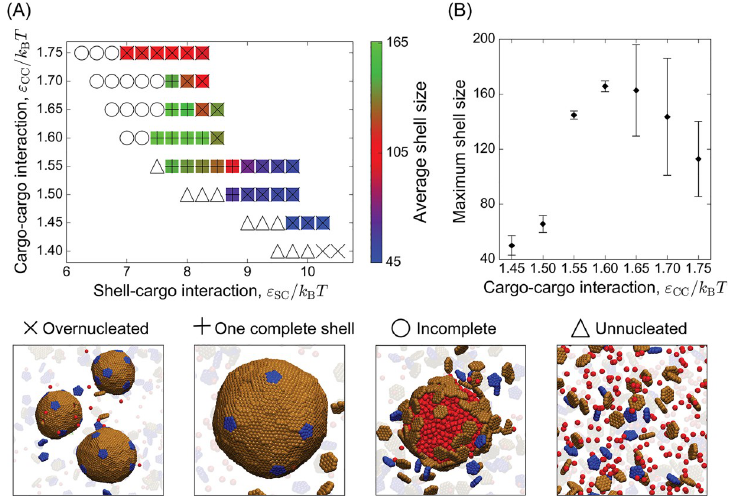
Fig 3. Dependence of the mean shell size and most probable morphology on the cargo-cargo and subunit-cargo affinities ( ε CC & ε SC ). (A) The mean shell size (number of hexamers + 12 pentamers) is indicated by the color bar, and the predominant morphology is indicated by symbols, with a snapshot corresponding to each morphology shown on the bottom. (B) The mean shell size maximized over ε SC is shown as a function of ε CC . Other parameters in (A) and (B) are